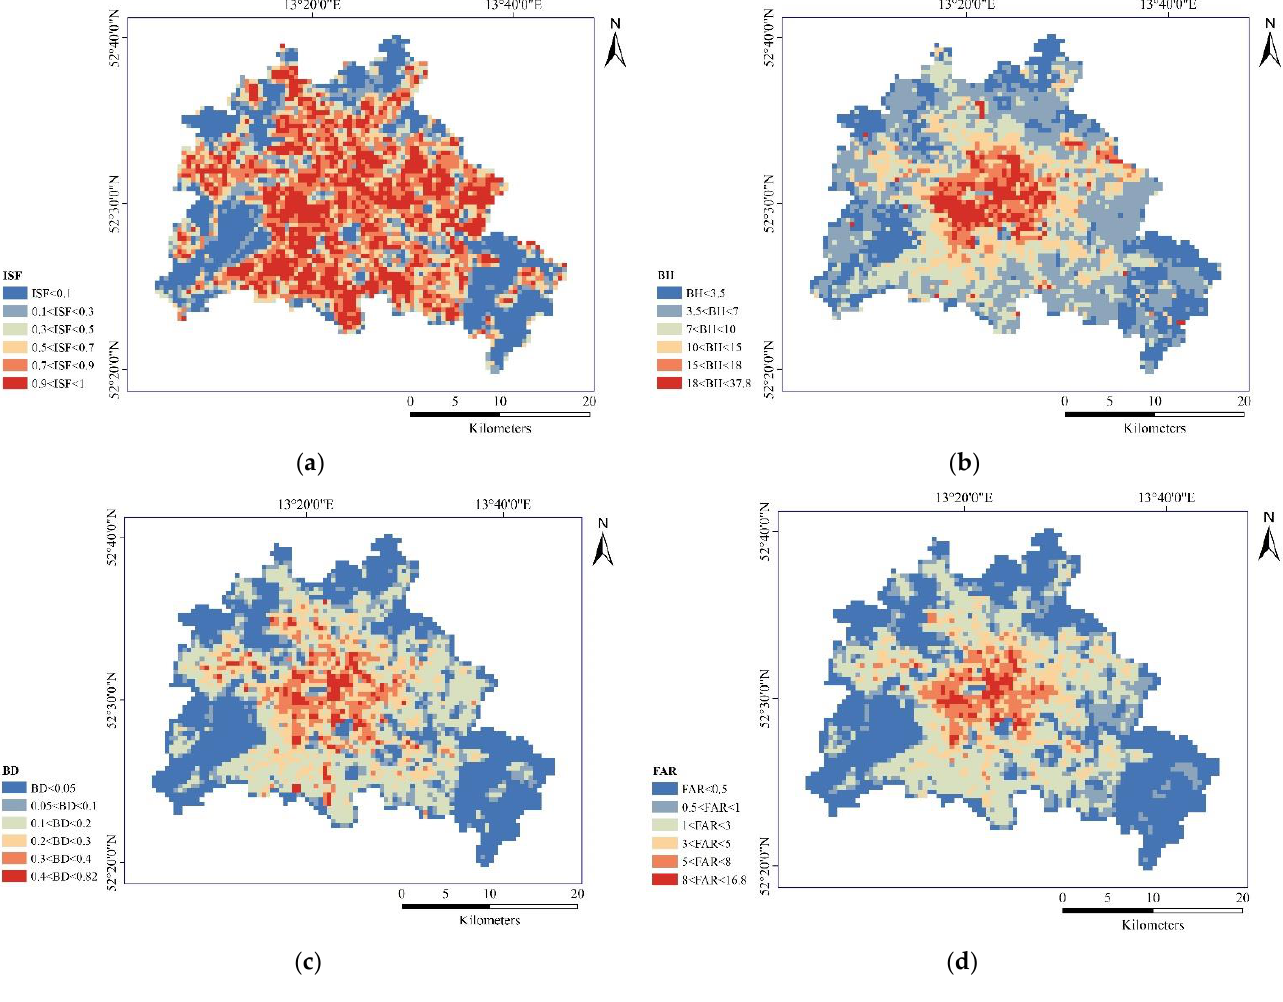
Figure 9. The spatial distributions of urban morphology indicators: ( a ) ISF; ( b ) BH; ( c ) BD; ( d ) FAR.